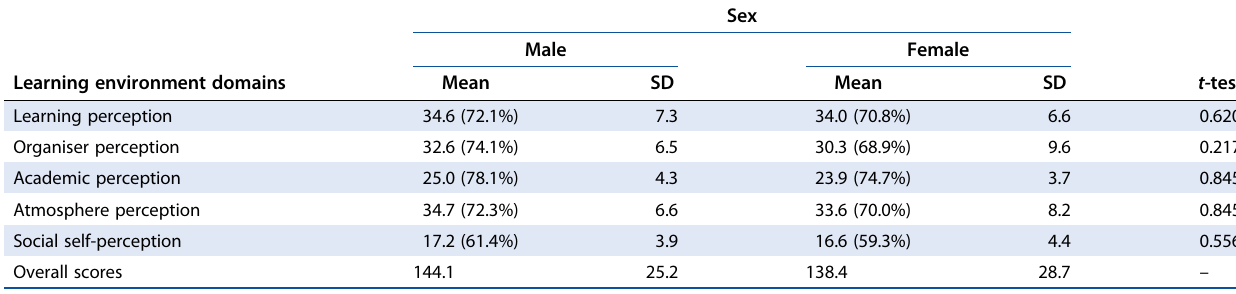
Table 3: Comparison of male and female perceptions of the learning environment